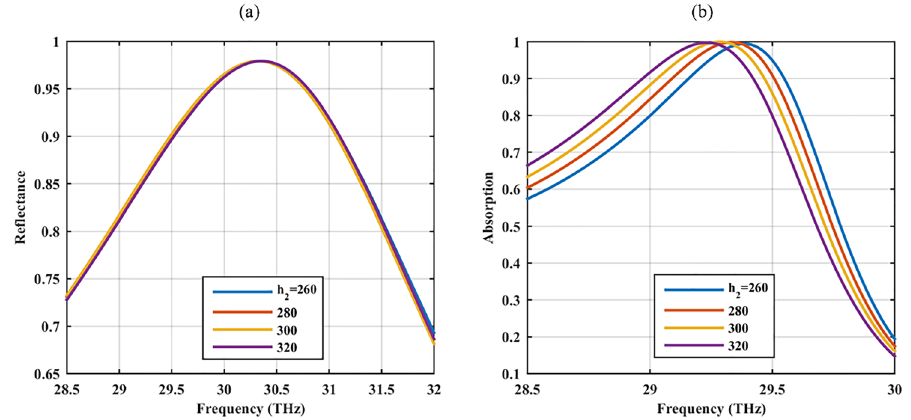
Figure 7. The optical ( a ) reflectance and ( b ) absorption of the proposed device respectively in the insulator and metallic phases of the VO 2 material for different h 2